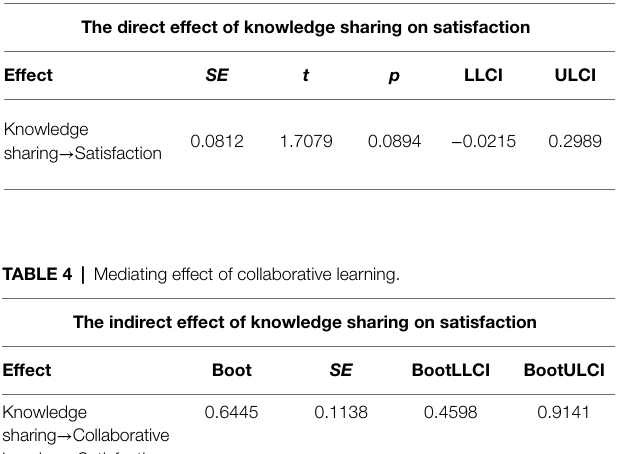
TABLE 3 | Direct relationship between knowledge sharing and satisfaction.